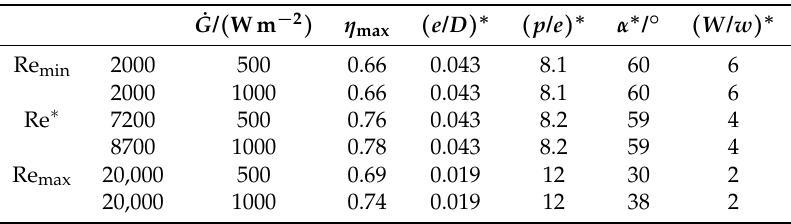
Table 1. Maximum efficiency and optimum roughness parameters according to the model developed by Hans et al.